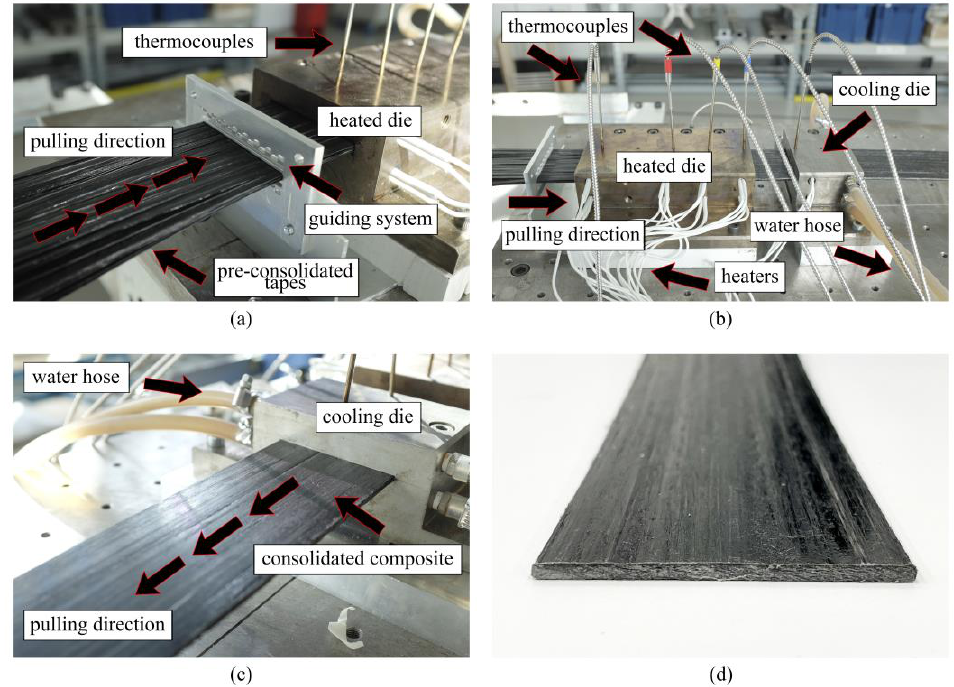
Figure 5. Pultrusion of thermoplastic flat GF/PP laminates based on commercial PCTs: ( a ) commercial PCTs entering the heated die; ( b ) die blocks during the pultrusion; ( c ) consolidated flat laminate leaving the cooling die block; ( d ) pultruded flat laminate.